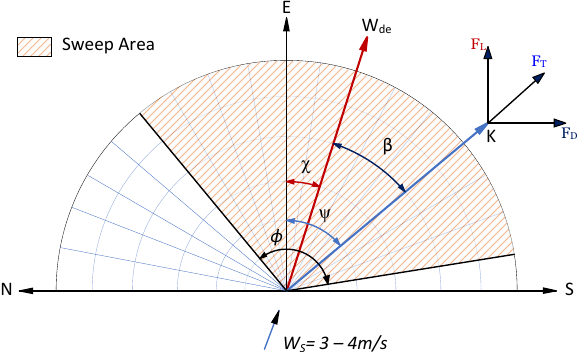
Figure 10. Wind window with shaded area indicating area swept by the kite in the figure-eight trajectory ( φ degrees); W de represents the wind direction vector; K represents kite tether vector; N, E, and S are the north, east, and south reference vectors; χ is the angle between east and W de ; ψ is the angle between east and the kite tether vector; β is the angle between W de and the kite tether vector.